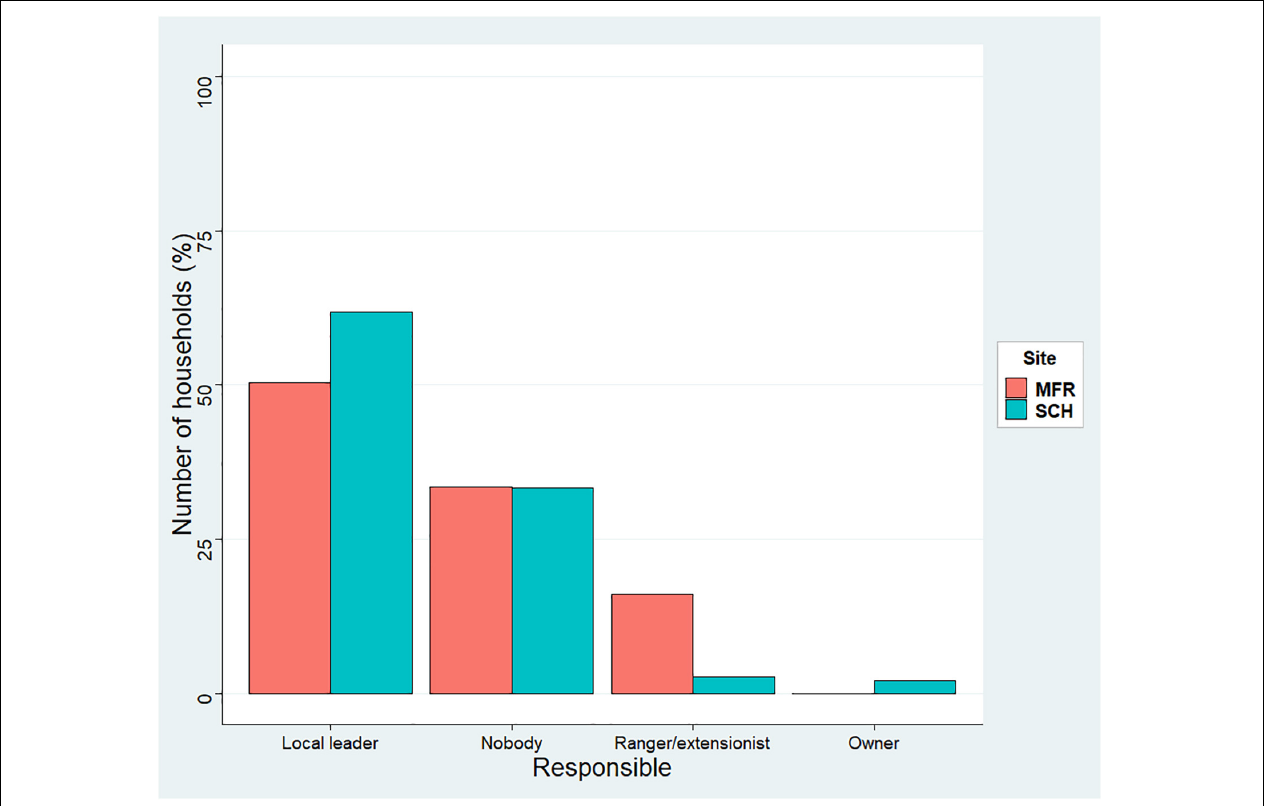
FIGURE 3 | Households’ perception about the institution responsible for control of forest use in MFR and SCH.